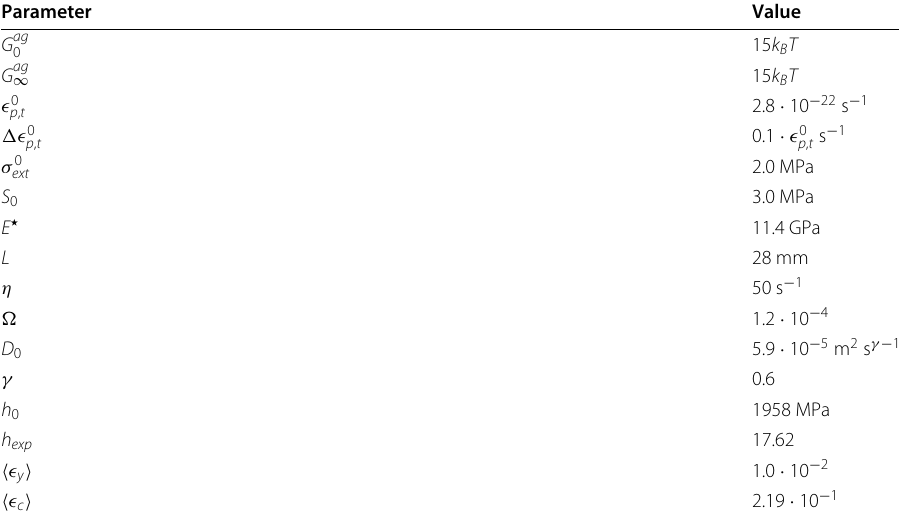
power-law (seen in Fig. 2b) was fitted. Finally (cid:8)(cid:2) 0 was set so that it best reproduces the p , t experimentally seen average fluctuations. The parameter values are in Table 1. The sam- ple was discretized into 200 sections to match the spatial resolution of the experiments and the evolution equations were numerically solved using the adaptive Dormand–Prince RK5(4)7M method (Dormand and Prince 1986). Analogously to the experiments the band movement was tracked by computing the strain rate maps and tracking the band front. Table 1 Parameter values for the model